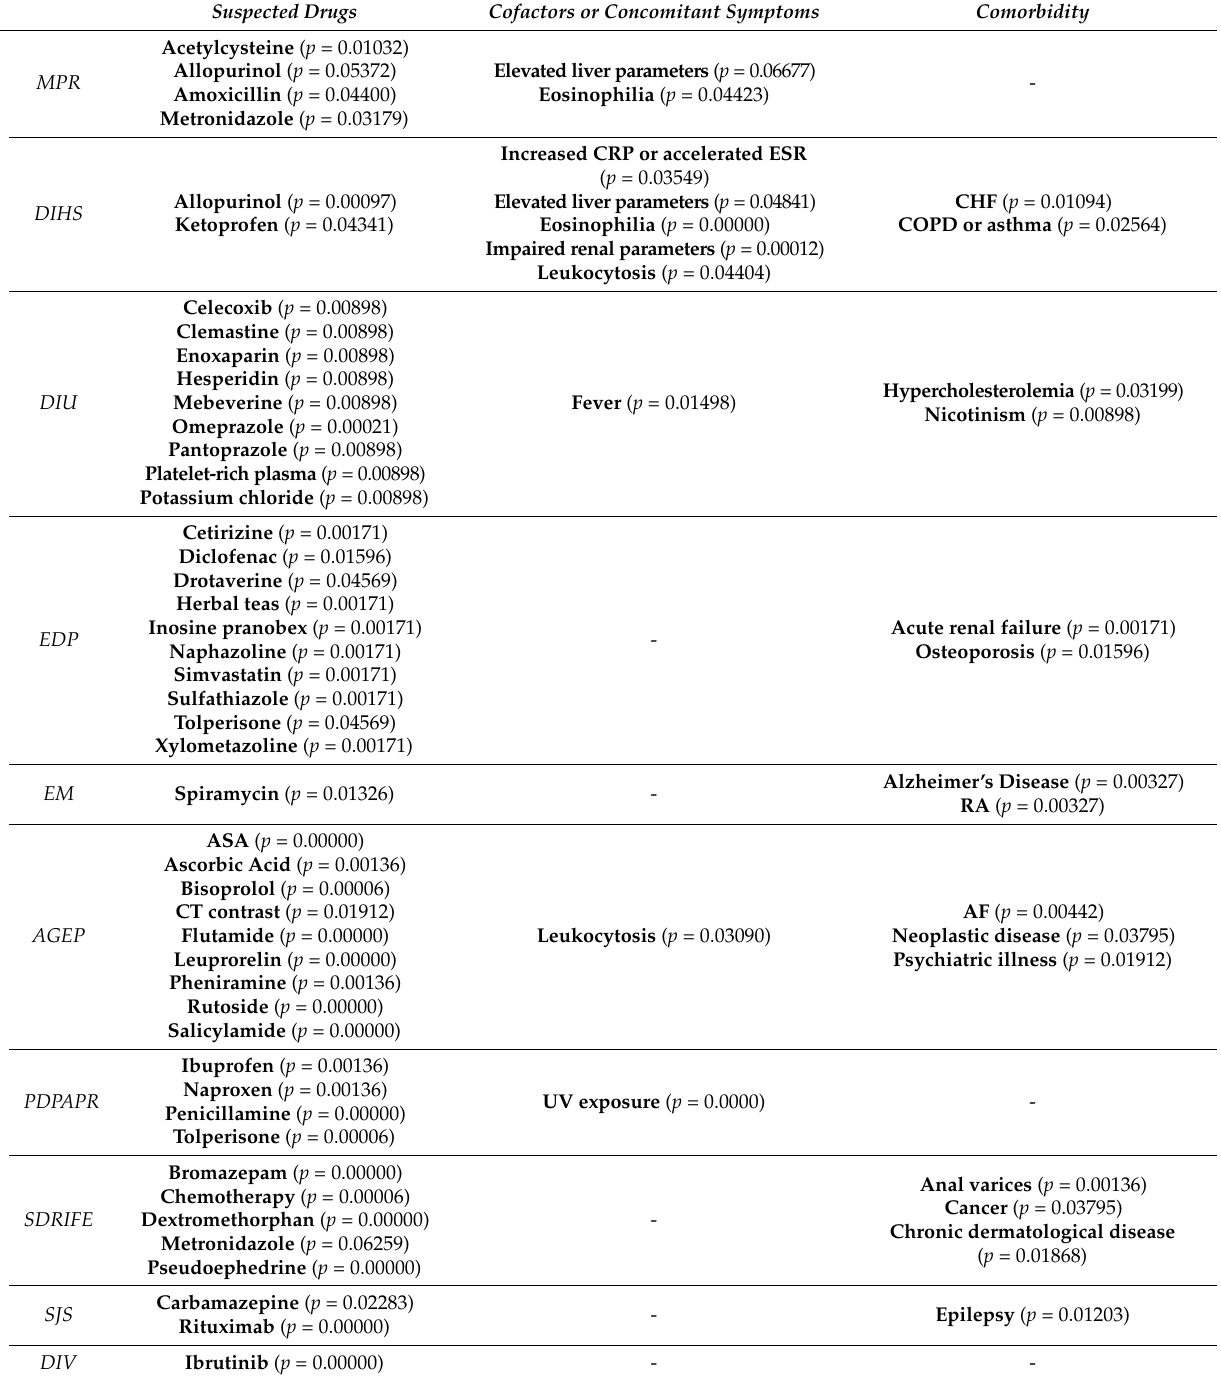
Abbreviations: AGEP, acute generalized exanthematous pustulosis; DIHS, drug-induced hypersensitivity syn- drome; DIU, drug-induced urticaria; DIV, drug-induced vasculitis; EDP, erythema dyschromicum perstans; EM, erythema multiforme; MPR, maculopapular rash; PDPAPR, post-drug phototoxic and photoallergic reactions; SDRIFE, symmetrical drug-related intertriginous and flexural exanthema; SJS, Stevens-Johnson